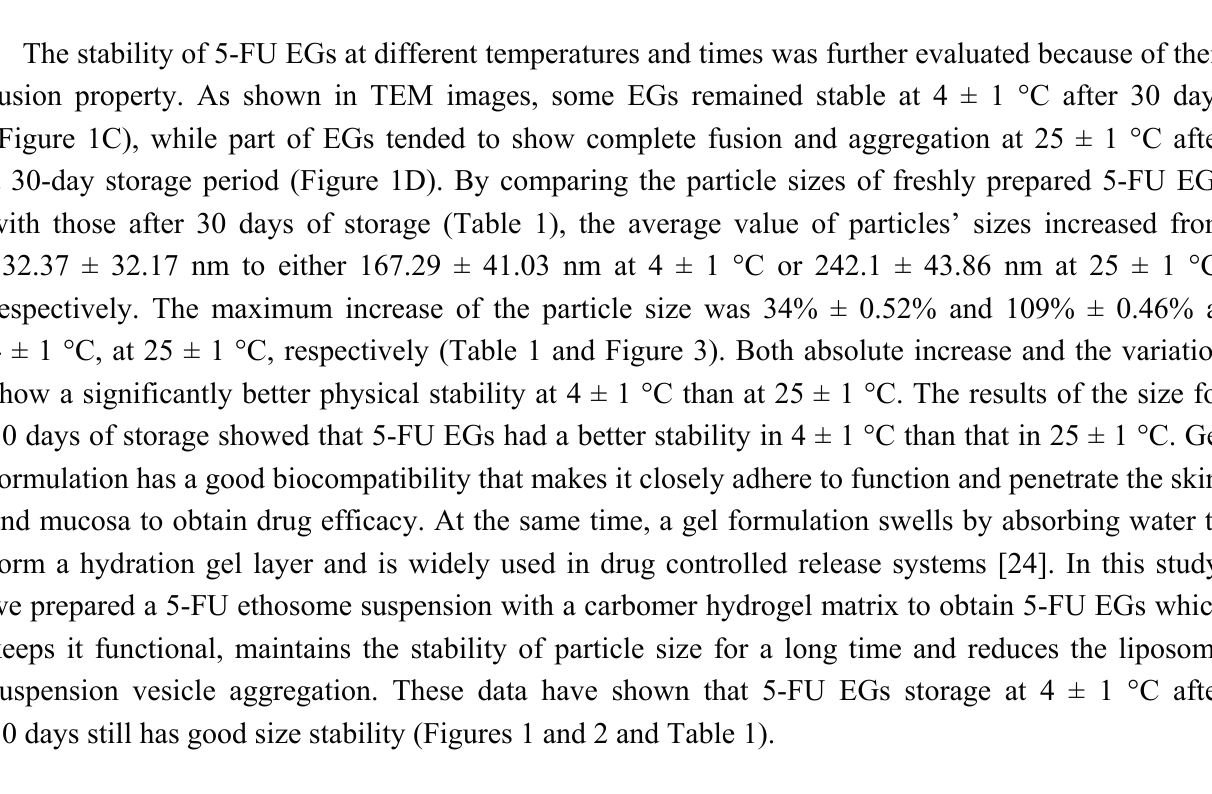
Table 1. Values of ethosome sizes loaded with 5-FU remained stable at different storage temperature for 30 days (nm) ( n =